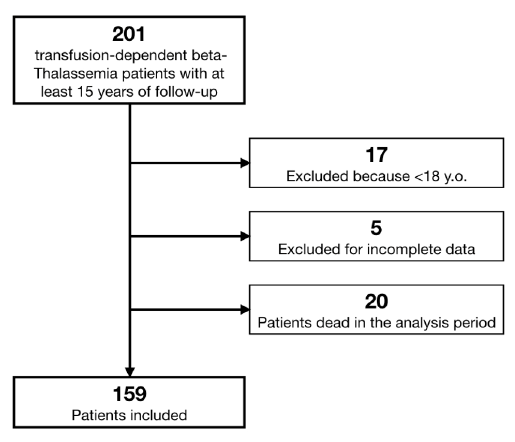
Figure 1. Study flow chart.